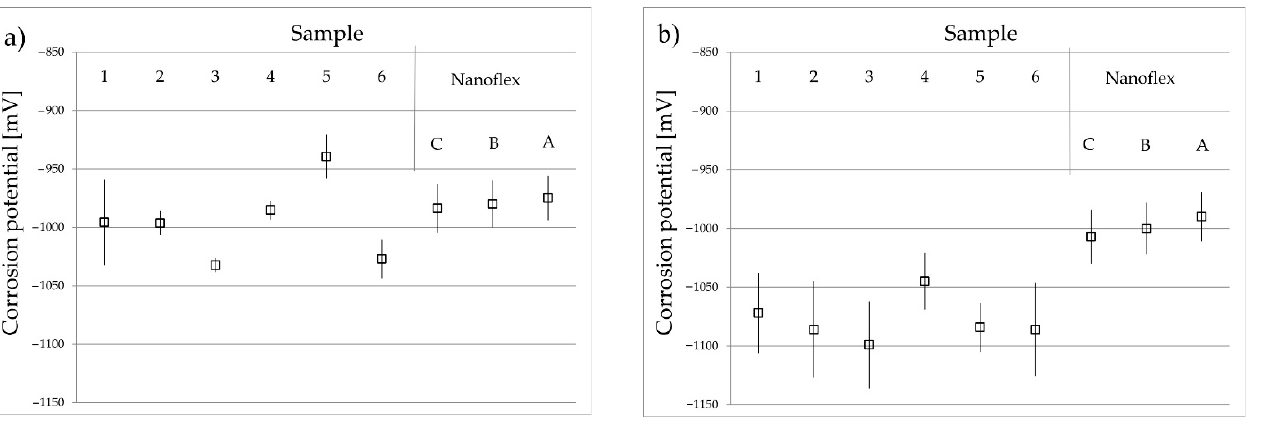
Figure 10. Values of corrosion potentials for nitrided layers and Nanoflex steel under conditions A, B and C. ( a ) Test in Ringer’s solution, ( b ) test in 3% NaCl in water.